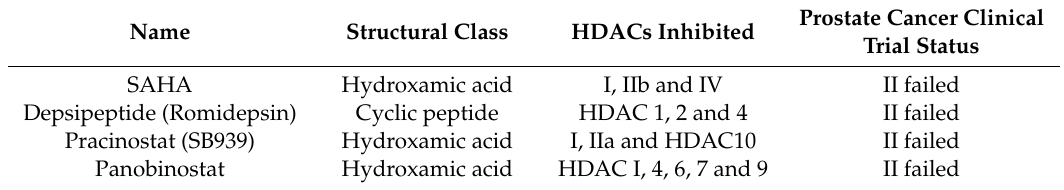
Table 4. HDAC inhibitors examined in clinical trials to treat prostate cancer